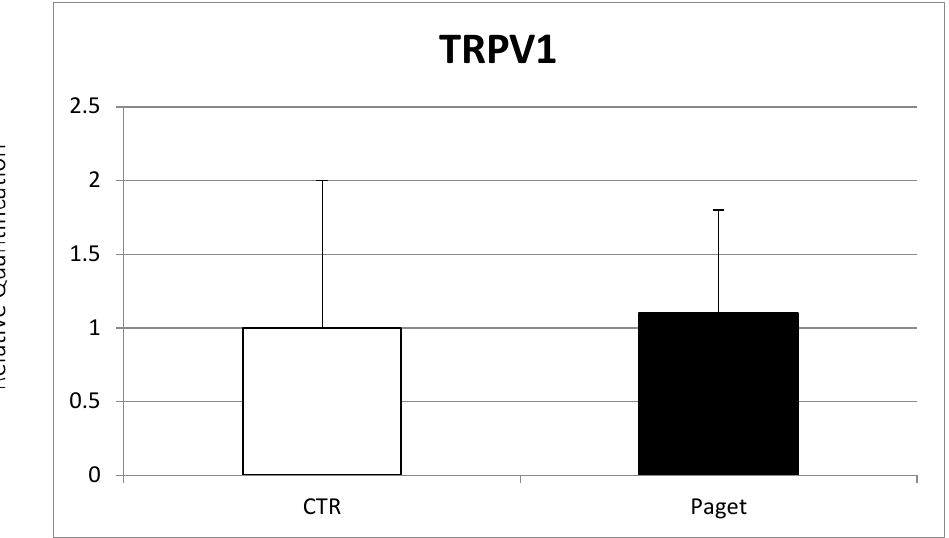
Figure 4. Comparison between TRPV1 mRNA expression evaluated with RT-PCR from 2 OCs of subjects with PDB and 2 healthy controls. Results were normalized for the housekeeping gene β -Actin and were showed as mean ± SD of three independent experiments on each individual sample.